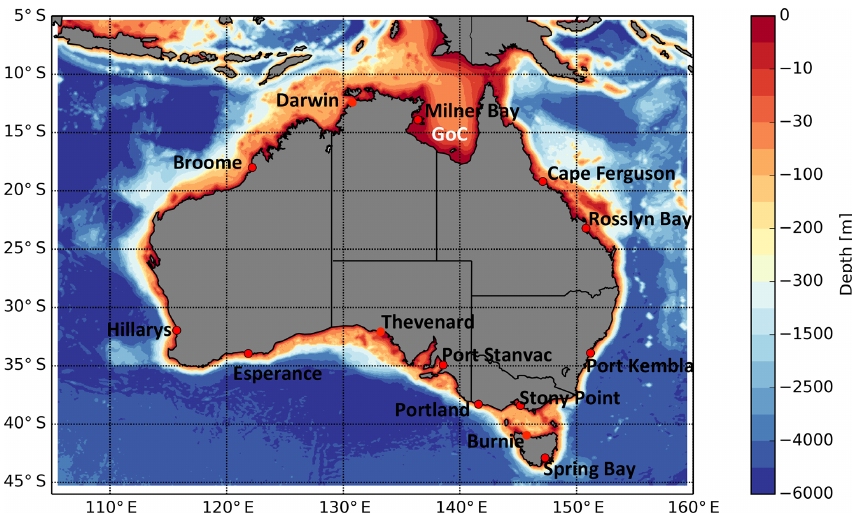
Figure 1. The region covered by the hydrodynamic model and bathymetric depth is shown. Red dots mark the locations of the tide gauges used for validation of baseline simulations listed in Table 2. The Gulf of Carpentaria is indicated by